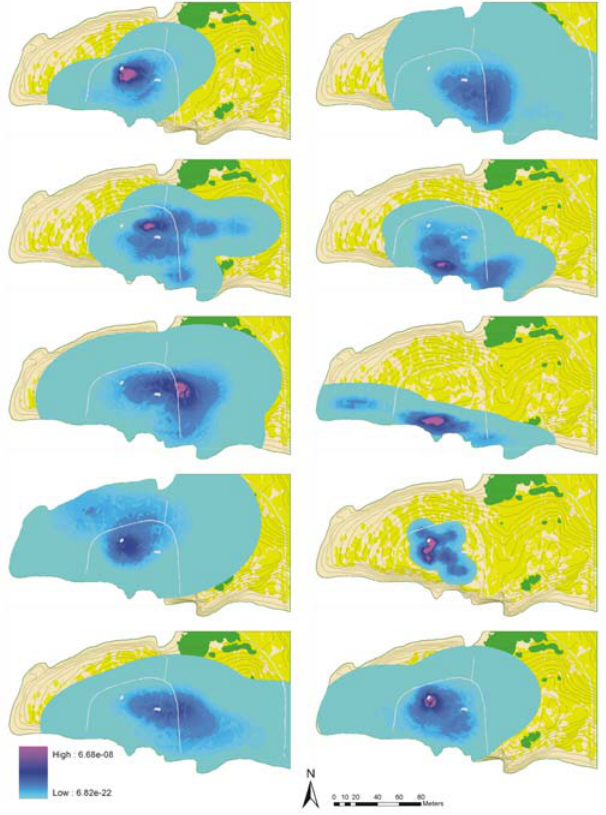
Figure 2. Plant recruitment kernels generated by each individual lizard. Probability of recruitment of each ingested seed (including post- dispersal seed predation, seedling emergence and survival) is showed as a colour gradient. The limit of the coloured area indicates the lizard home range.